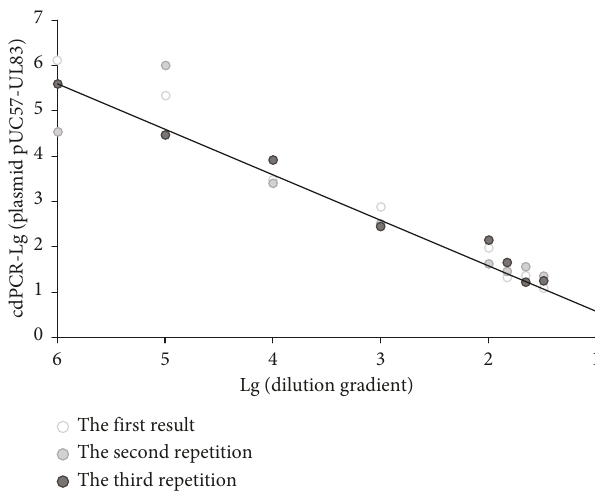
Figure 1: Variations of HCMV DNA copies of cdPCR compared with a standard curve. The black line shows the standard curve of the plasmid DNA. Different scatter points are the HCMV DNA copies tested by cdPCR. Table 1: Comparisons between qPCR and